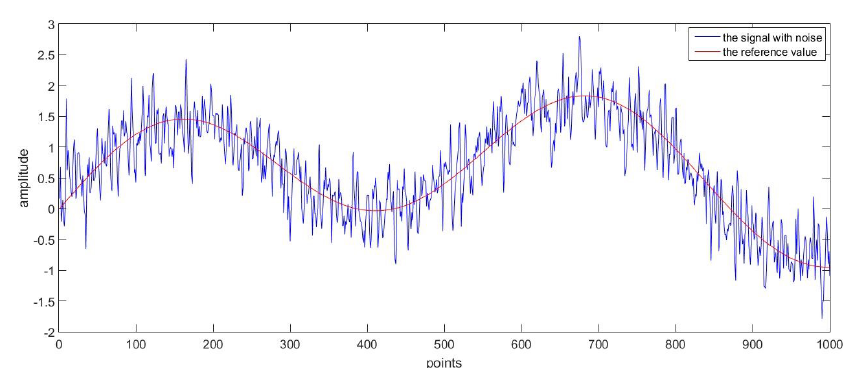
Figure 12. The reference value and the signal with